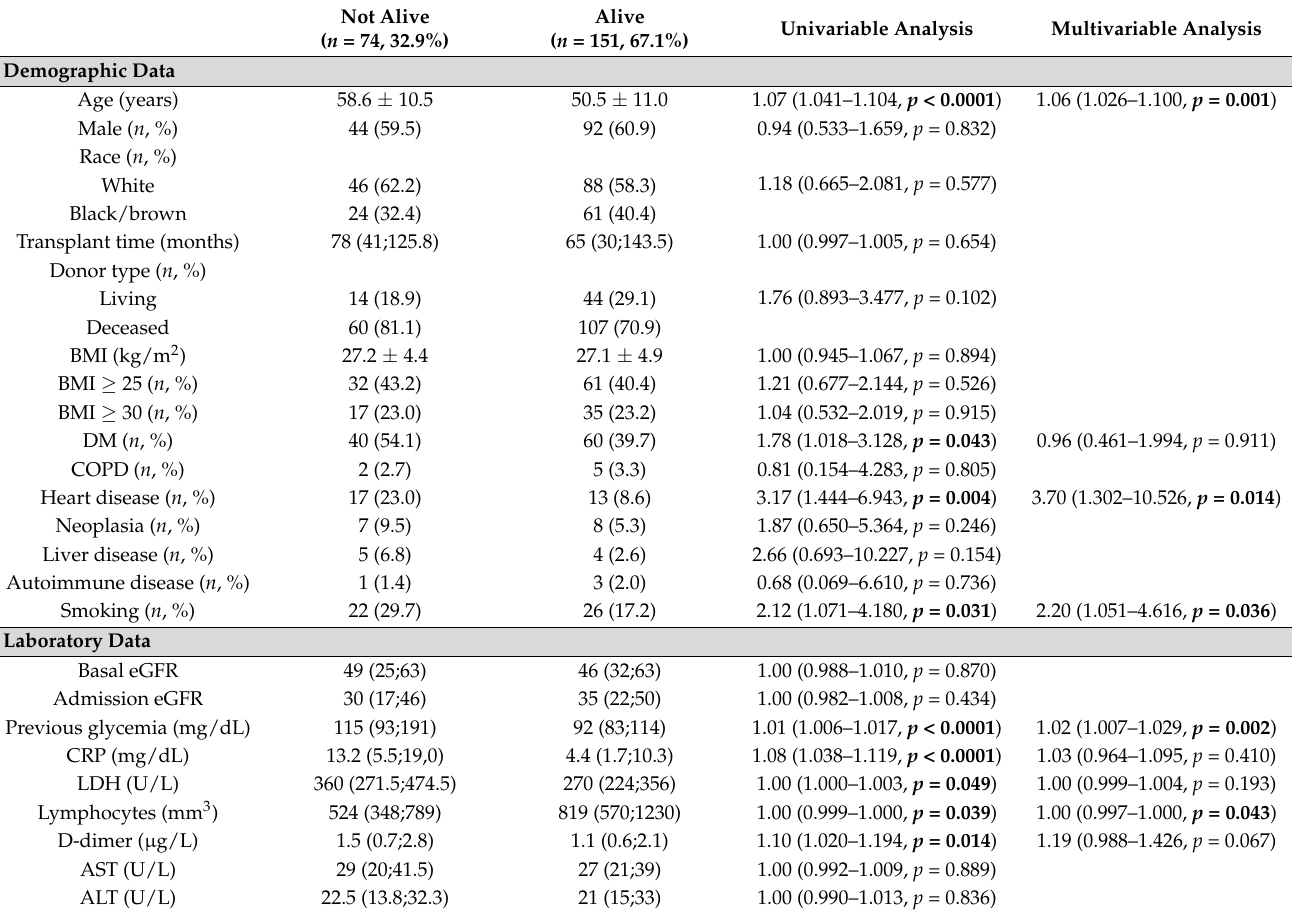
Table 2. Risk factors for mortality in kidney transplant recipients with hypertension (HTN). Not Alive Alive ( n = 74, 32.9%) ( n = 151, 67.1%)